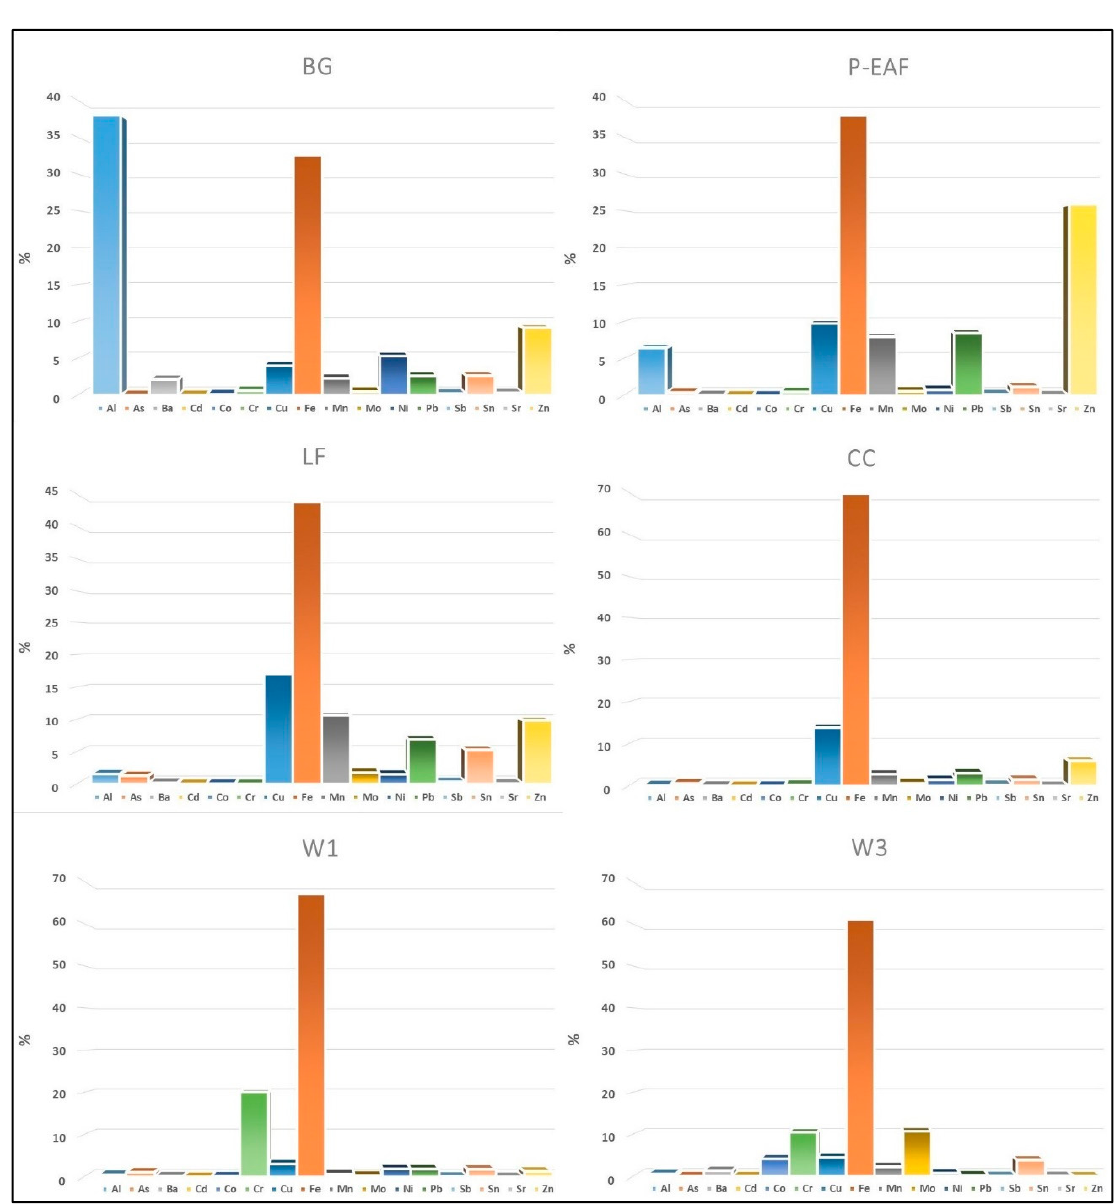
Figure 5. Concentration of metallic elements (percentage values) analysed in the ultrafine particulate collected by ELPI+ at the several sampling sites.